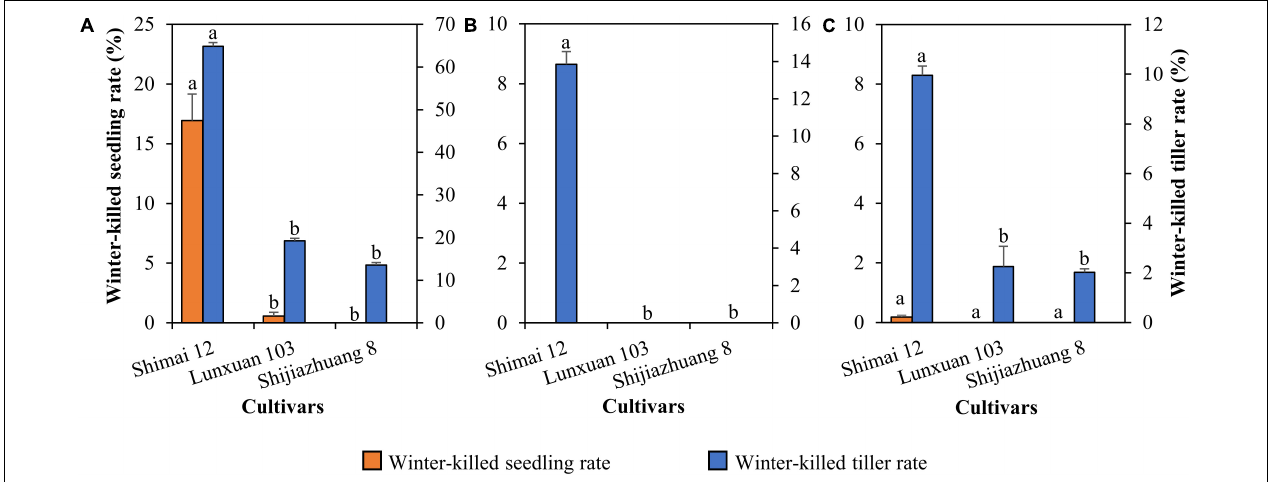
FIGURE 2 | Comparison of freeze-killed seedlings and tillers for Lunxuan 103 and its parents Shijiazhuang 8 and Shimai 12 at 2018SY (A) , 2018ZX (B) , and 2019SY (C) . Multiple comparisons for each trait were performed using the least significant difference (LSD) test and different letters above the error bars indicate significant differences among cultivars at P <